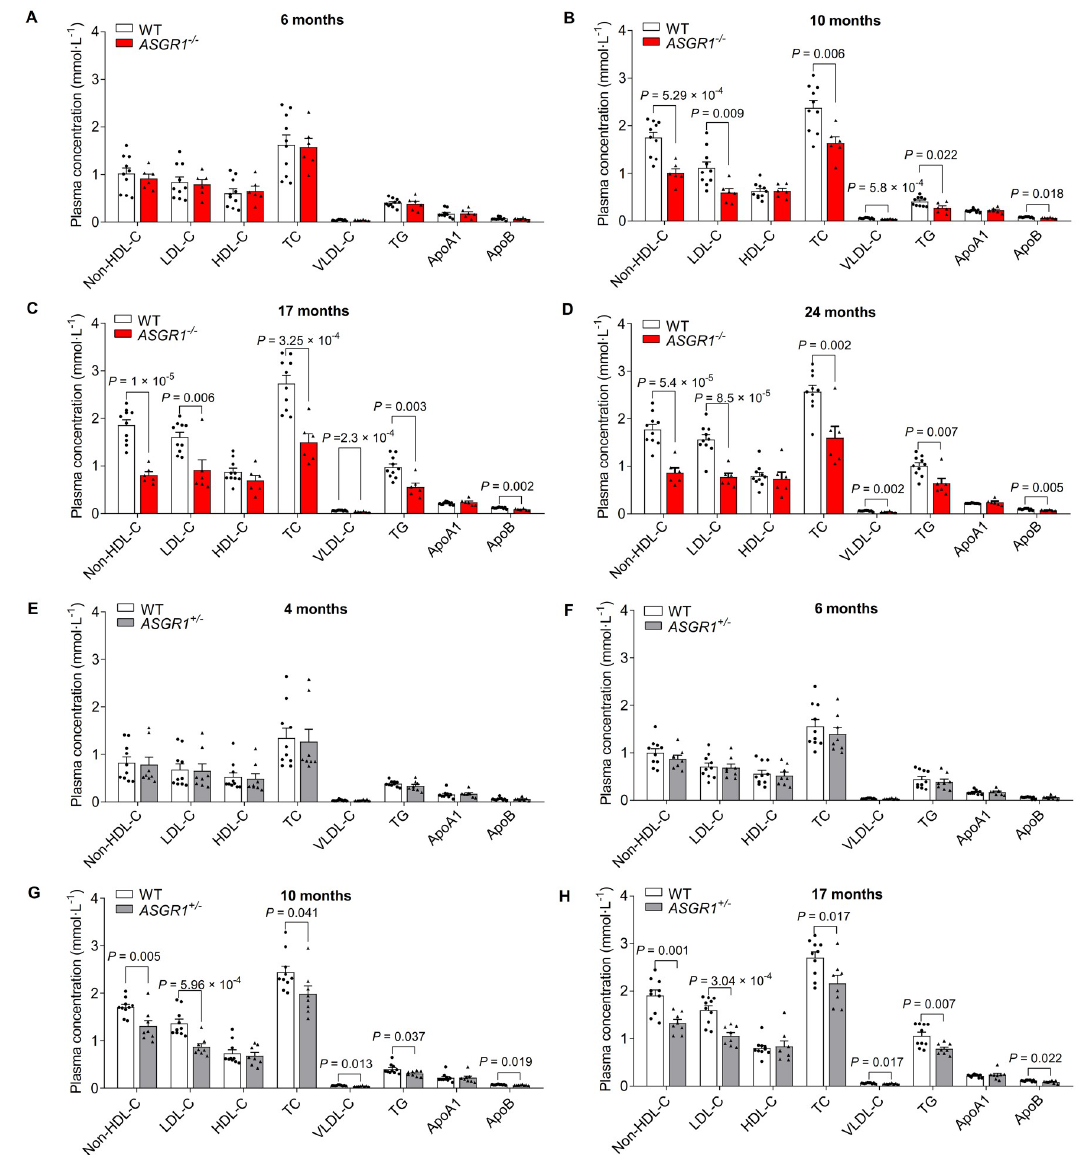
Fig 2. Plasma lipoprotein profiles of pigs under standard diet. A-D . The effect of age on levels of non-HDL-C, LDL-C, HDL-C, TC, VLDL-C TG, ApoA1 and ApoB in ASGR1 -/- pigs and WT controls receiving a standard diet ( n = 6 for ASGR1 -/- pigs, n = 10 for WT controls. Data represent two independent experiments combined). E-H . The effect of age on levels of non-HDL-C, LDL-C, HDL-C, TC, VLDL-C TG, ApoA1 and ApoB in ASGR1 +/- pigs and WT controls receiving a standard diet. Points indicate data from individual pigs ( n = 8 for ASGR1 +/- pigs, n = 10 for WT controls. Data represent two independent experiments combined). P values are shown for indicated comparisons by the Student’s t -test. Values are mean ± SEM. The underlying data for this figure can be found in S1 Data